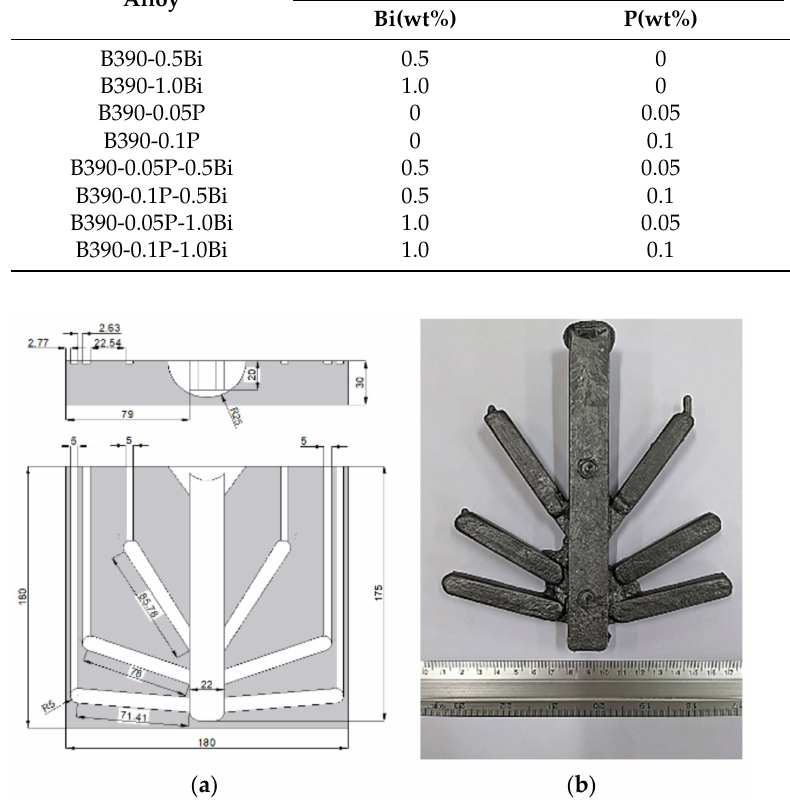
Figure 1. ( a ) Steel mould (scale: mm) and ( b ) as-cast